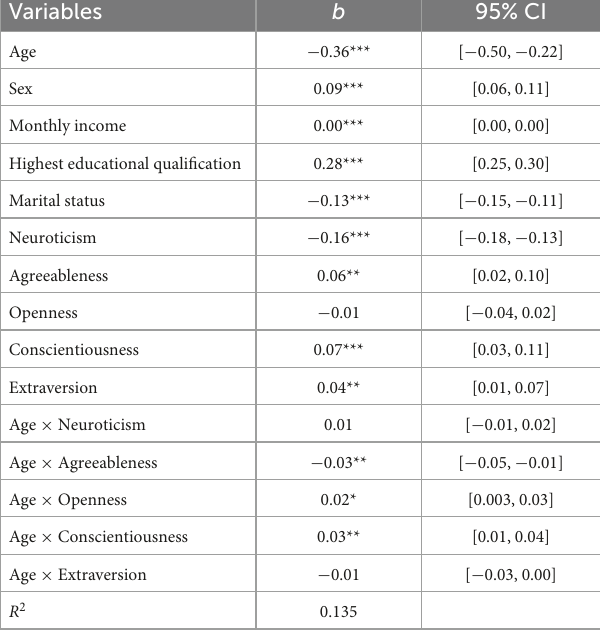
TABLE 3 The regression coefficient ( b ) for demographics, personality traits, and age (categorical) by personality traits interactions with the total explained variances ( R 2 ).